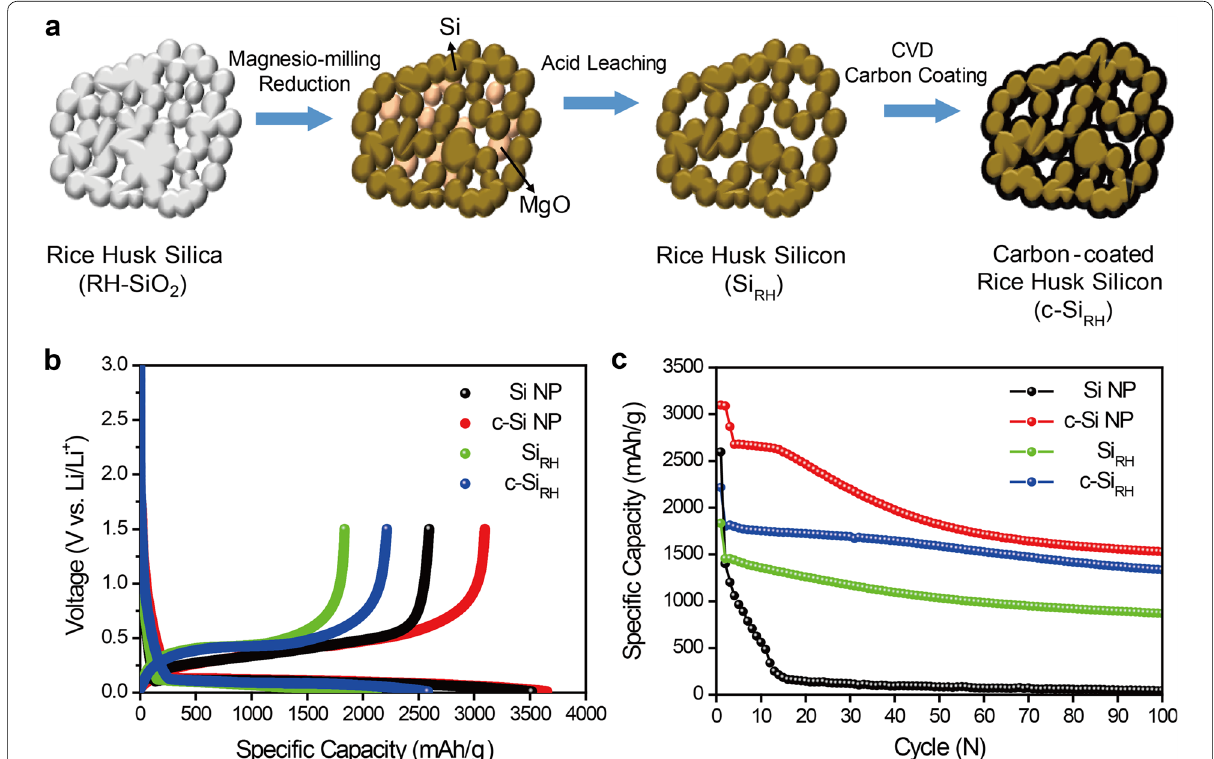
Fig. 1 a Schematic illustration of synthesis of the carbon-coated rice husk silicon. Electrochemical measurements of various silicon electrodes. b Potential profiles in the first cycles at 50 mA/g and c cycling performance at 2000 mA/g of Si NP, c-Si NP, Si RH and c-Si RH